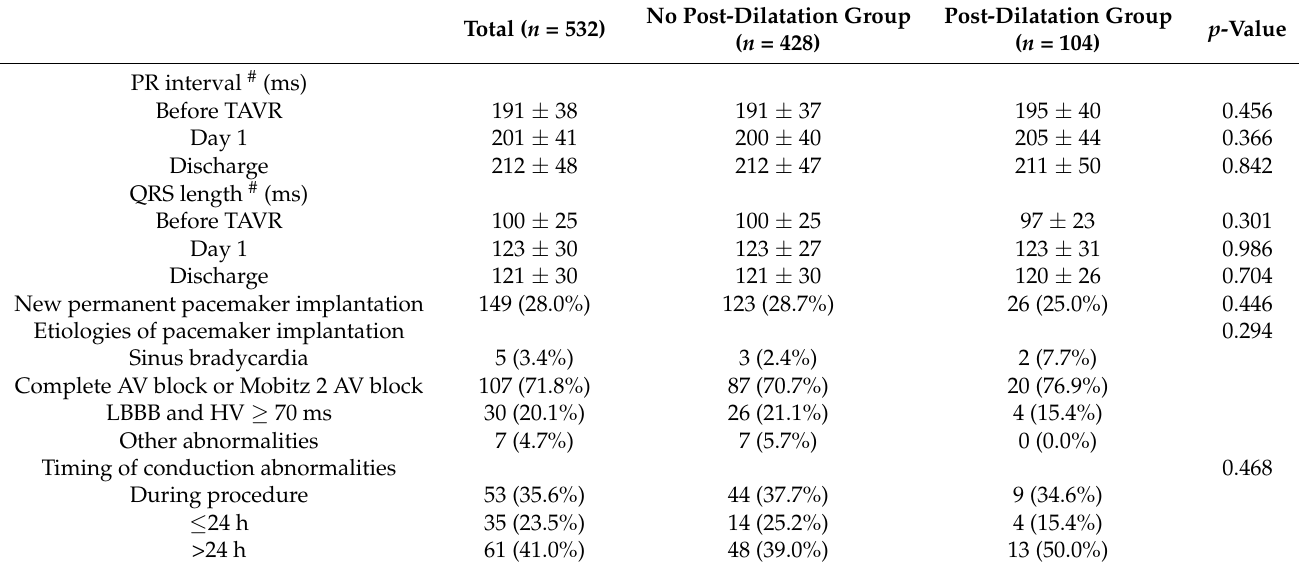
Table 3. Electrocardiogram description and electrical conduction